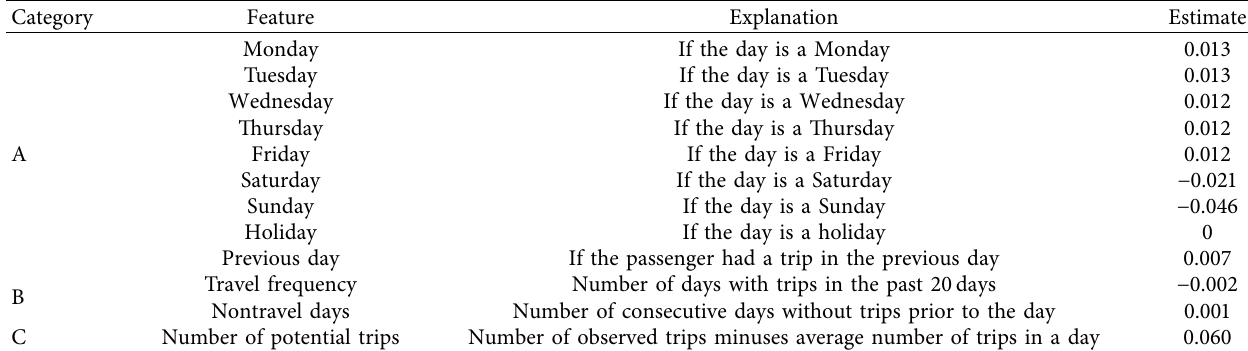
Table 2: List of prediction features for